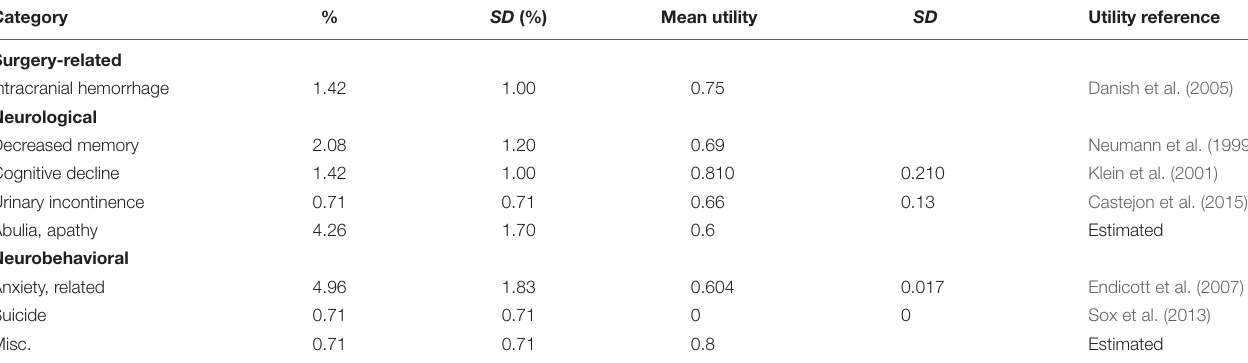
TABLE 1 | Postoperative RF Complications—Pooled Frequency and Utility. Category % Mean utility Utility reference